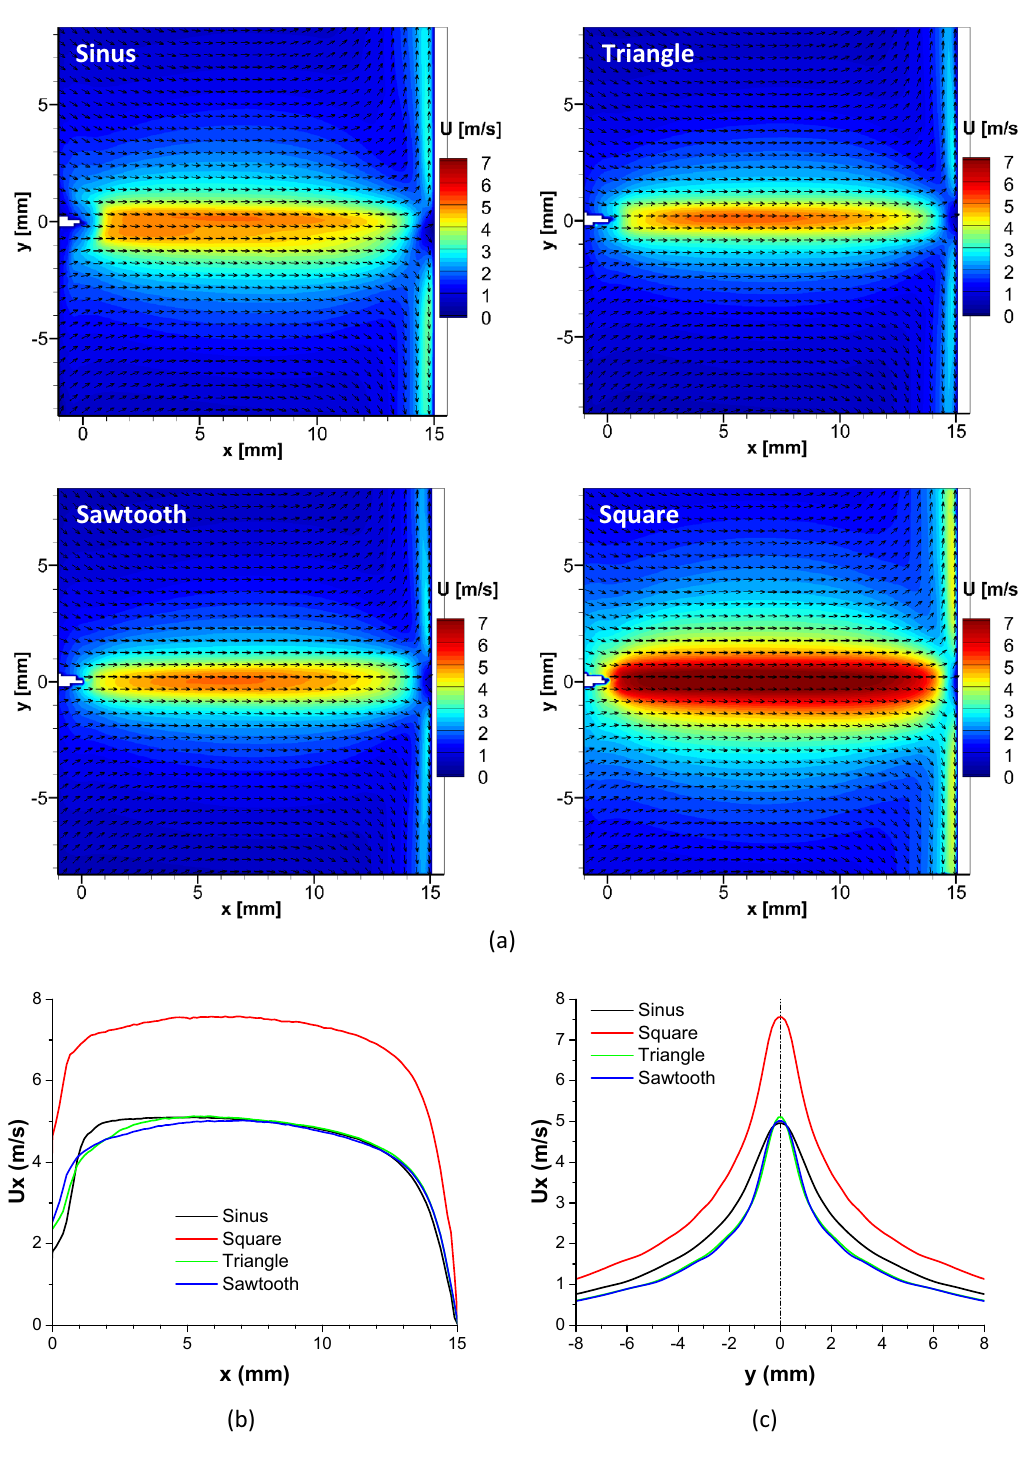
Figure 3. Velocity fields of the produced ionic wind for different voltage waveforms at V AC = 14 kV and f AC = 500 Hz ( a ). Horizontal velocity profiles at y = 0 ( b ) and vertical velocity profiles at x = 5 mm ( c ) for different voltage waveforms (V AC = 14 kV and f AC = 500